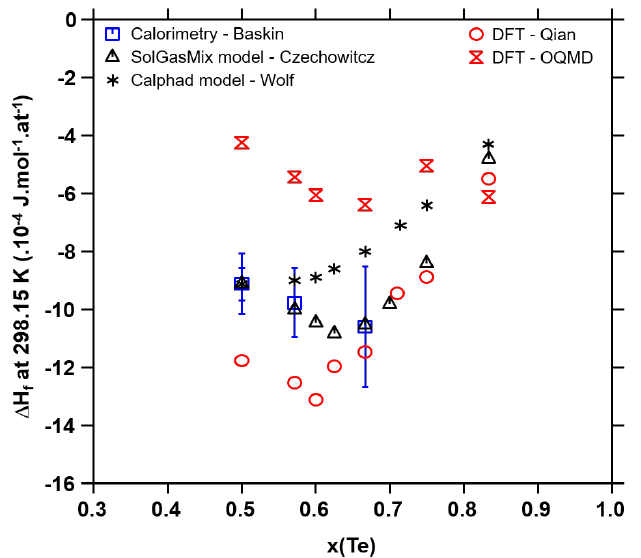
Figure 1. Enthalpy of formation data of the U x Te y compounds coming from the literature. The uncertainty bars on the experimental data measured by calorimetry (in blue) are